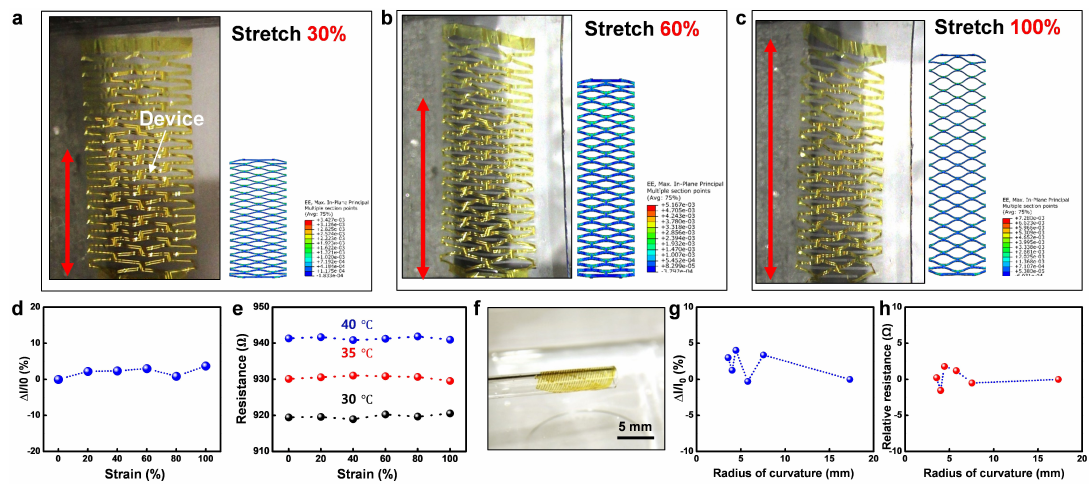
Figure 6. Stretchability and flexibility of the device: ( a ) Optical image and FEA of the device under 30% tensile strain. ( b ) Optical image and FEA of the device under 60% tensile strain. ( c ) Optical image and FEA of the device under 100% tensile strain. ( d ) Photocurrent change regarding the tensile strain up to 100%. ( e ) Resistance versus strain under temperatures of 30 ◦ C, 35 ◦ C, 40 ◦ C. ( f ) The device is wrapped around a glass tube. ( g ) Photocurrent versus bending radius from 3.5 mm to 17.3 mm. ( h ) Resistance change of the temperature sensor under bending radius from 3.5 mm to 17.3